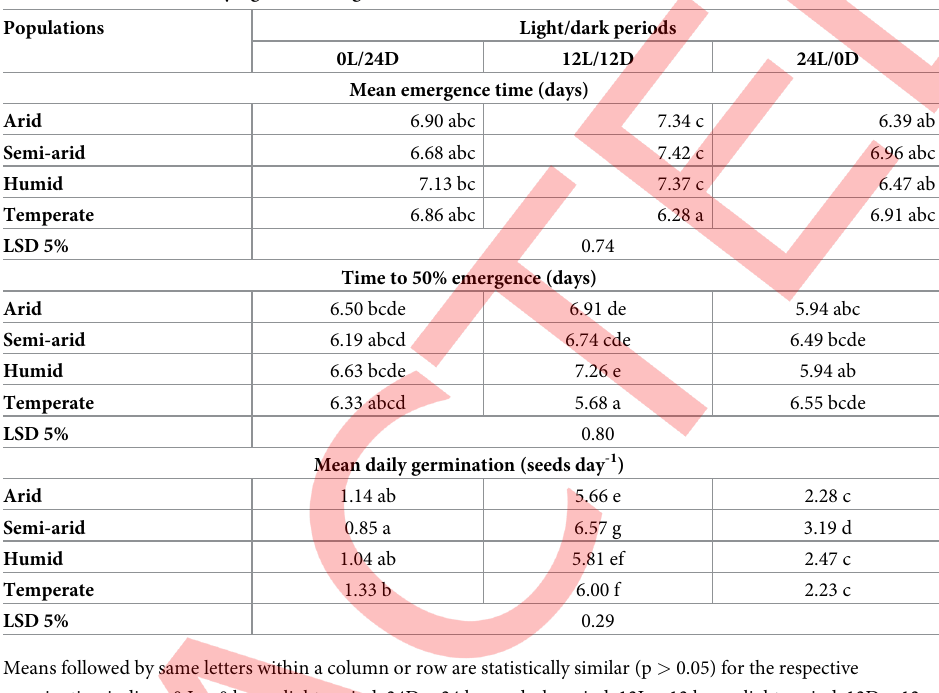
Table 3. The impact of different light/dark durations on various germination indices of Conyza sumatrensis pop- ulations collected from varying climatic regions.